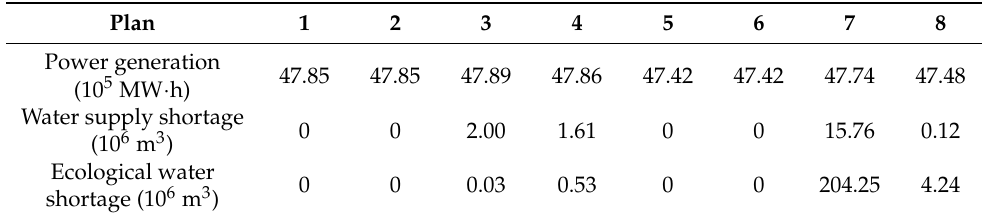
Table 6. The set of typical plans calculated by the MTIM and MTNM in a wet year.